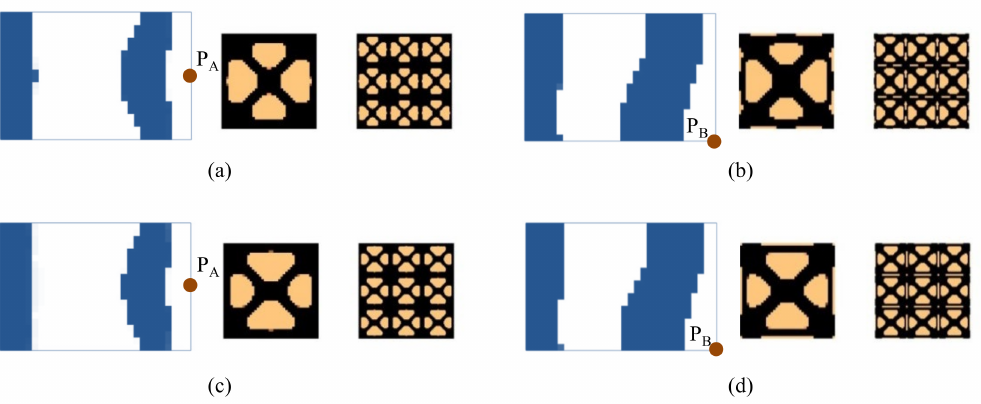
Figure 10. Design results with different initial guesses and excitation positions. The excitation